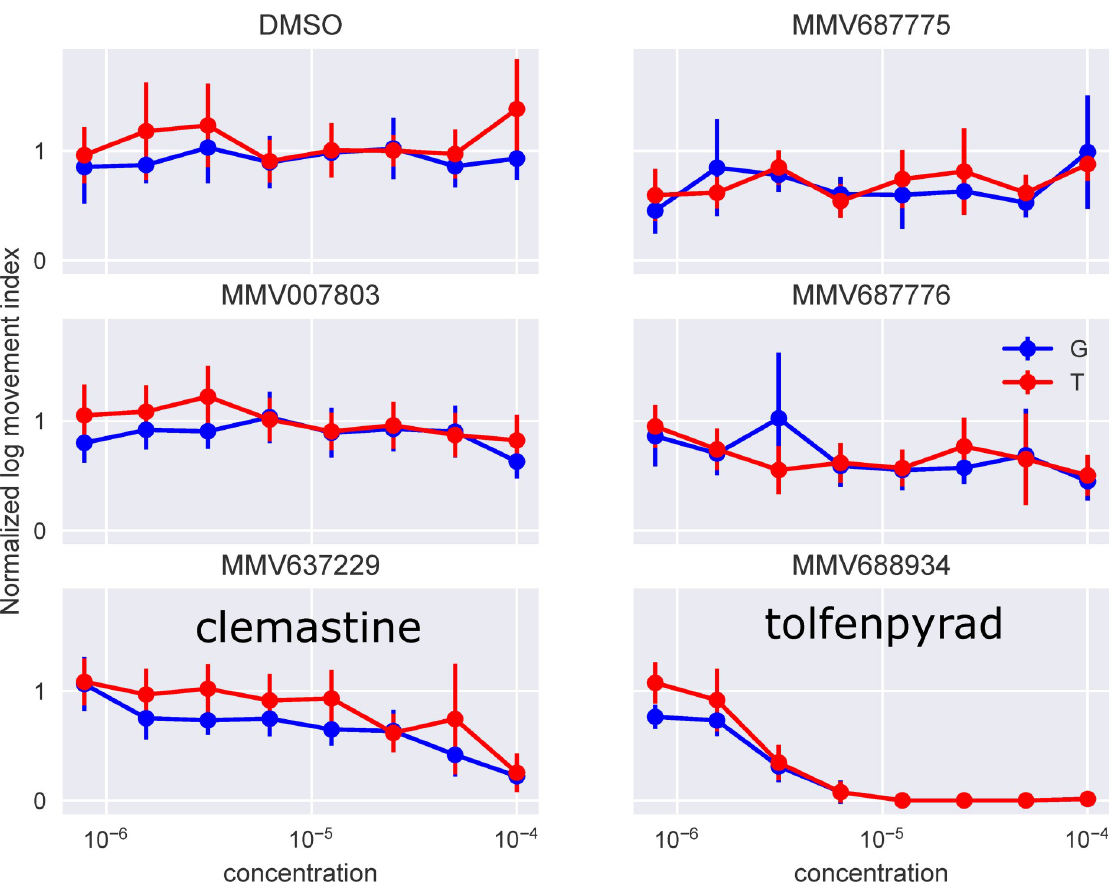
Fig 2. Screening a chemical library on An . gambiae larvae using the INVAPP / Paragon system. Concentration response curves for the five compounds in the Medicines for Malaria Venture (MMV) Pathogen Box library identified as active in the primary screen. The movement index for each well was measured before adding the compounds, and then again 240 min later. The second reading is divided by the first to normalize for background variations between the wells caused, for example, by differences in the number of larvae dispensed in each well. The compounds were applied over the range 3.0 × 10 − 9 M—1.0 × 10 − 4 M, although only concentrations above 7.8 × 10 − 7 M are shown for clarity. Larval progeny from both resistant An . coluzzii (Tiassale) and sensitive An . gambiae (G3) strains were studied and labelled “G” and “T” in the figure respectively. Of the compounds tested, only MMV688934 (tolfenpyrad) and MMV637229 (Clemastine) have chemical names. cup bioassays (Fig 4). The WHO assay yielded logLC s of 8.60 ± 0.04 (LC50 = 2.5 nM) and 50 7.29 ± 0.14 (LC50 = 51.3 nM) for New Orleans and Cayman respectively (2-tailed, indepen- dent t-test, T(4) = -3.9, P = 0.0). The inhibition and resistance ratios were estimated from the